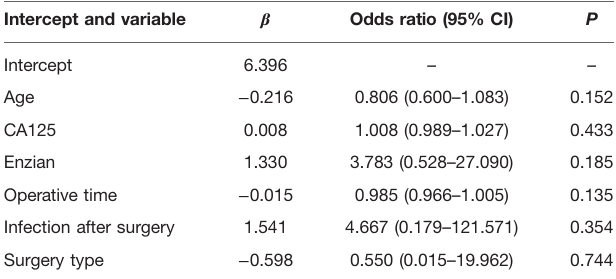
TABLE 3 | Predictors for complication after conservative surgery of intestinal deep endometriosis. Intercept and variable